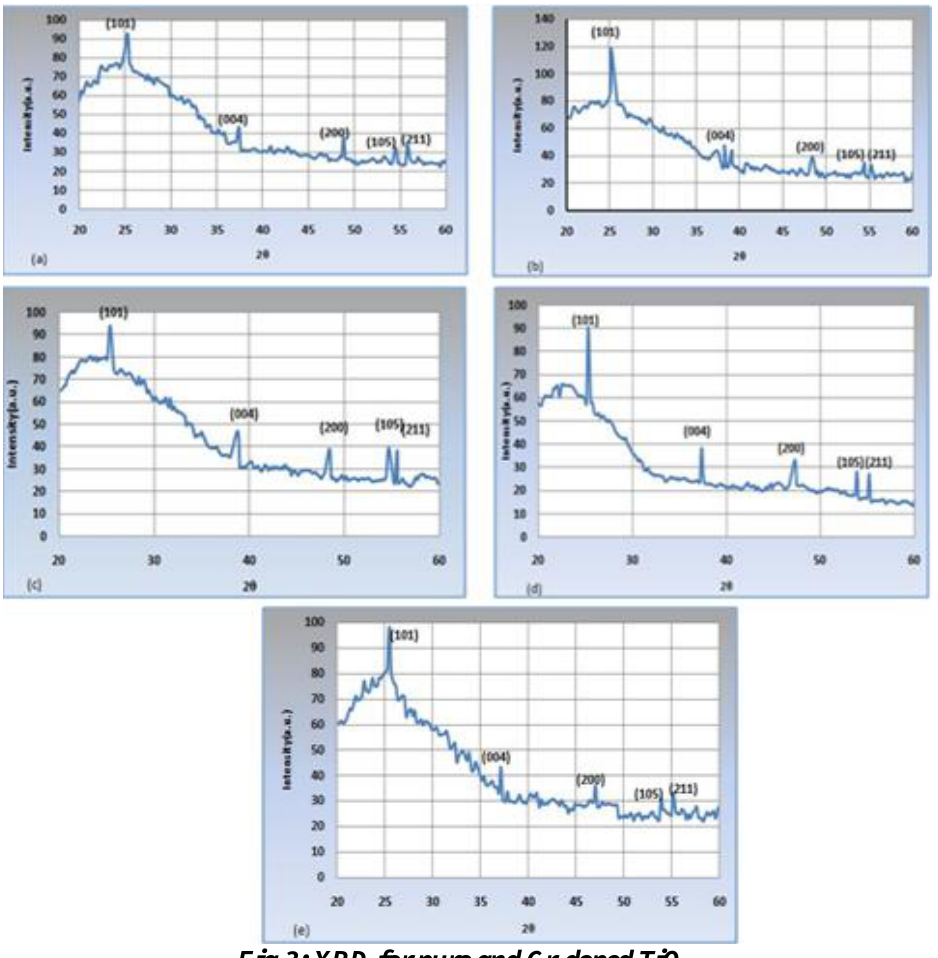
Fig.3: XRD for pure and Cr-doped TiO